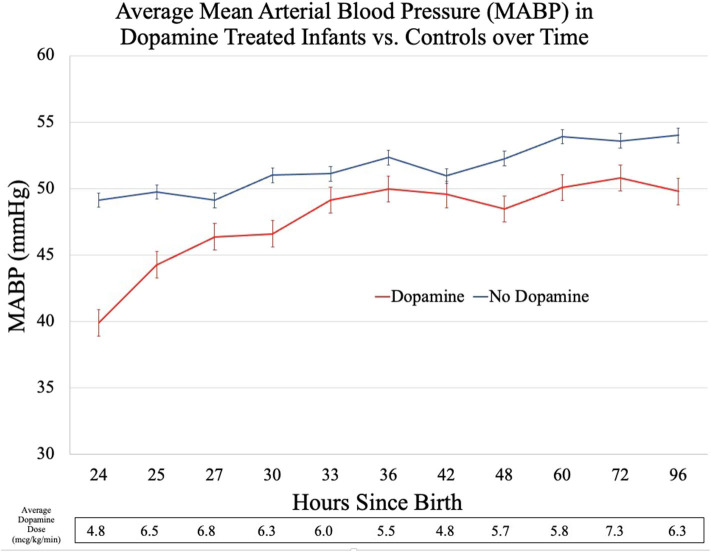
Hemodynamic changes: MABP in dopamine treated infants vs. controls.